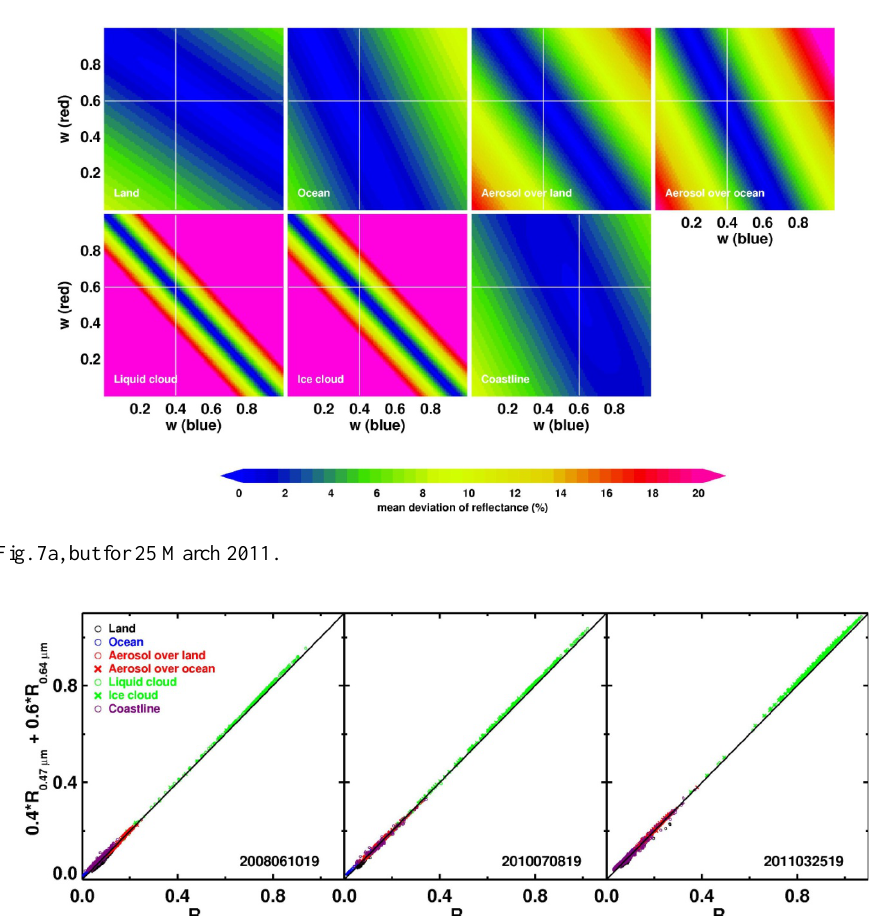
Figure 7 Fig. 7. Comparison of the synthesized and simulated green band reflectance, where the synthesized green band reflectance is derived from the blue and red band reflectance. The coastline are produced with a different blue-red combination such as G syn = 0 . 6 · B + 0.6 · R